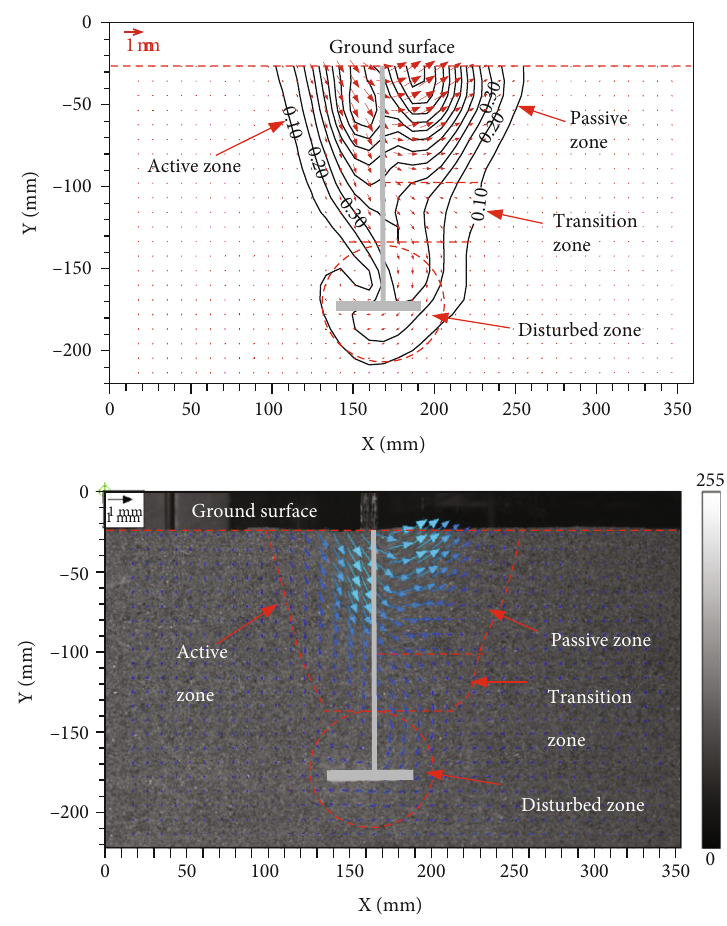
Figure 4: Displacement fi eld at the ultimate load under conditions of D